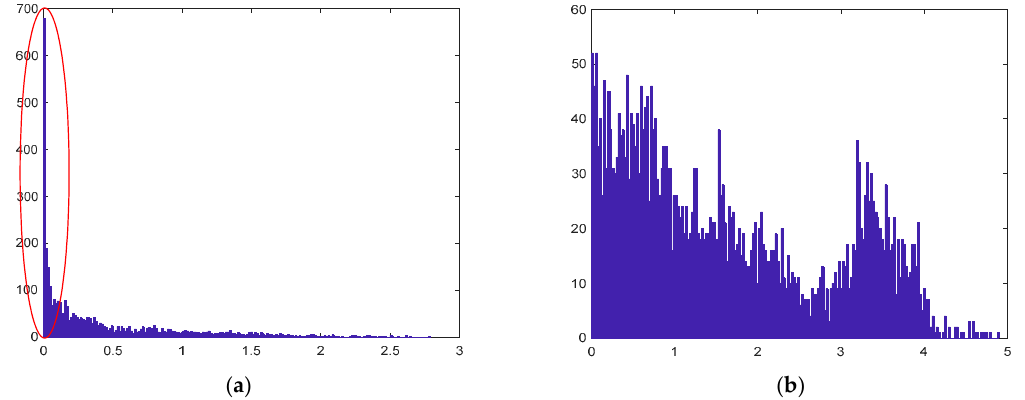
Figure 1. The X -axis represents the residual value, and the Y -axis represents the number of model hypotheses votes. ( a ) The residual histogram of an inlier. Peak appear in bands with small residual value, which is corresponding to the true model. ( b ) The residual histogram of an outlier. Most residual values are large and there is no obvious peak in the whole band.